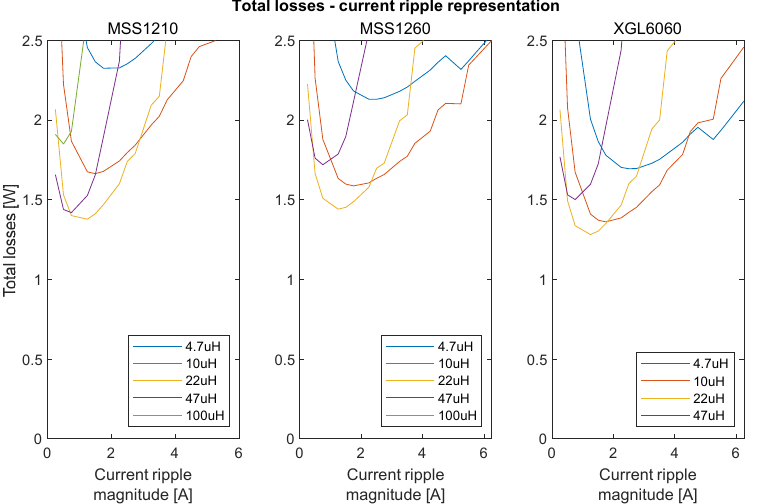
Figure 23. Model results for the three inductor families. Total losses are represented as a function of the Current Ripple and the inductor values. Table 4. Calculated losses at global optimums for each series and individual main inductor losses at these